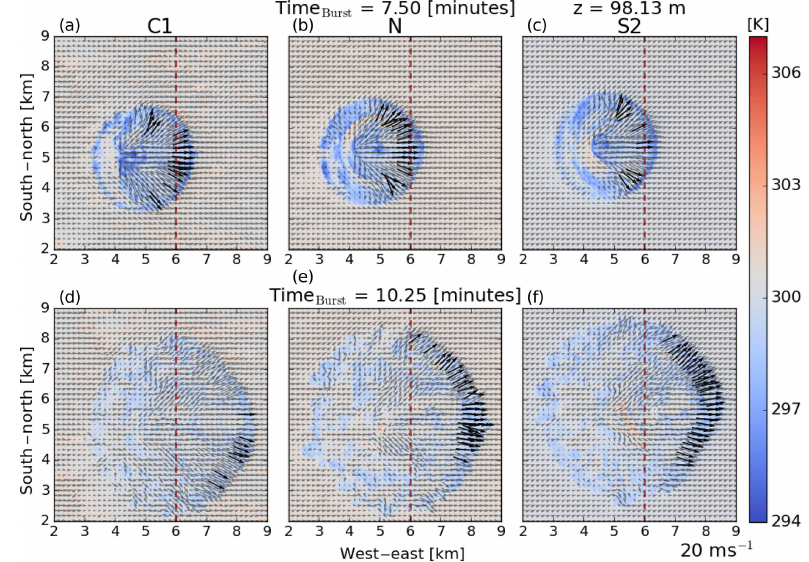
Figure 5. Horizontal cross sections at 98.13m for the C1–5x_5y (a, d) , N–5x_0y (b, e) , and S2–0x_5y (c, f) cases at time burst = 7 . 5min (a, b, c) and 10.25min (d, e, f) . Filled contours show the temperature (K) with arrows representing the horizontal wind field at this level. The locations with wind speeds above 20ms − 1 are shaded in black, while locations with wind speeds below this threshold are shaded in gray. The north–south-oriented line denotes the location at which a vertical slice is recorded at every time step used to generate the time series in Fig.